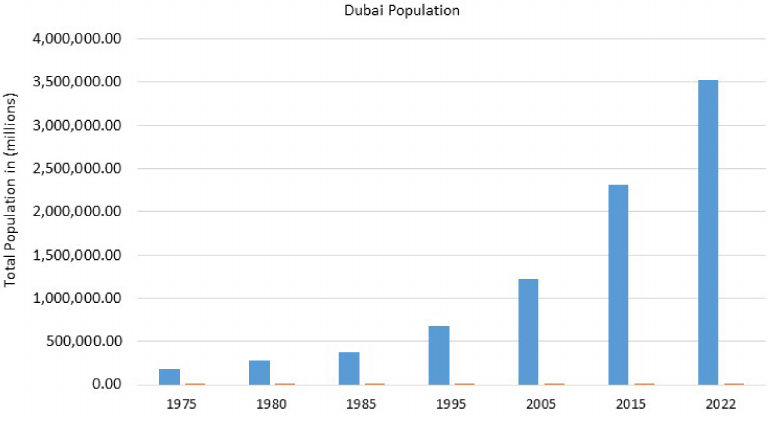
Figure 6. Bar graph showing the population of Dubai from